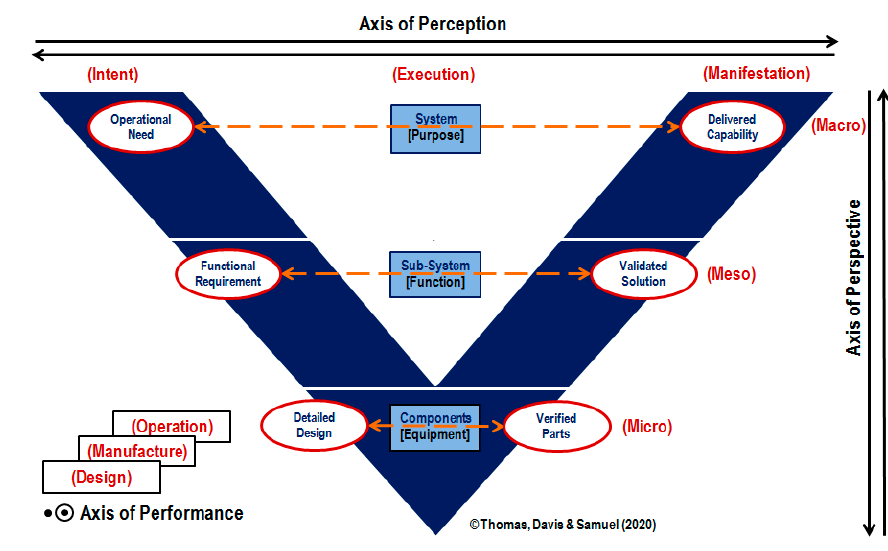
Figure 15. Integration-in-Totality Principle, Depicted in the V-Model of Systems Engineering.